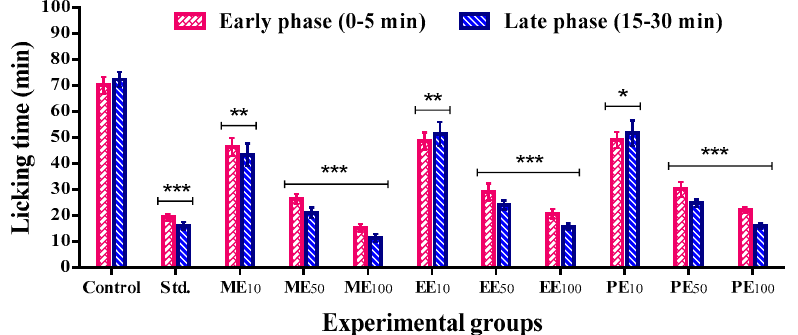
Figure 6. Licking time of ester prodrugs of ketoprofen assessed by using formalin induced paw licking method. Data was expressed as mean ± SEM, where n = 5. A value of *** p < 0.001, ** p < 0.01 and * p < 0.05 vs. control was considered significant.